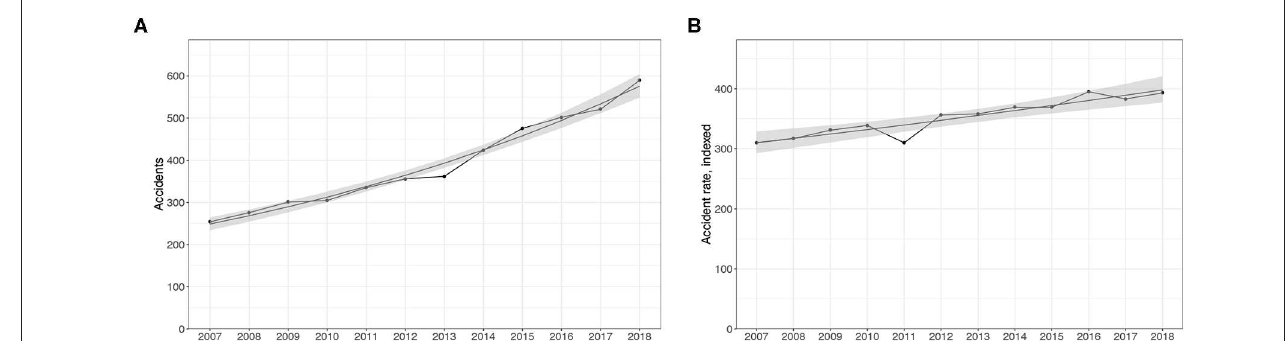
FIGURE 2 | Accident numbers without (A) and with (B) corrections.